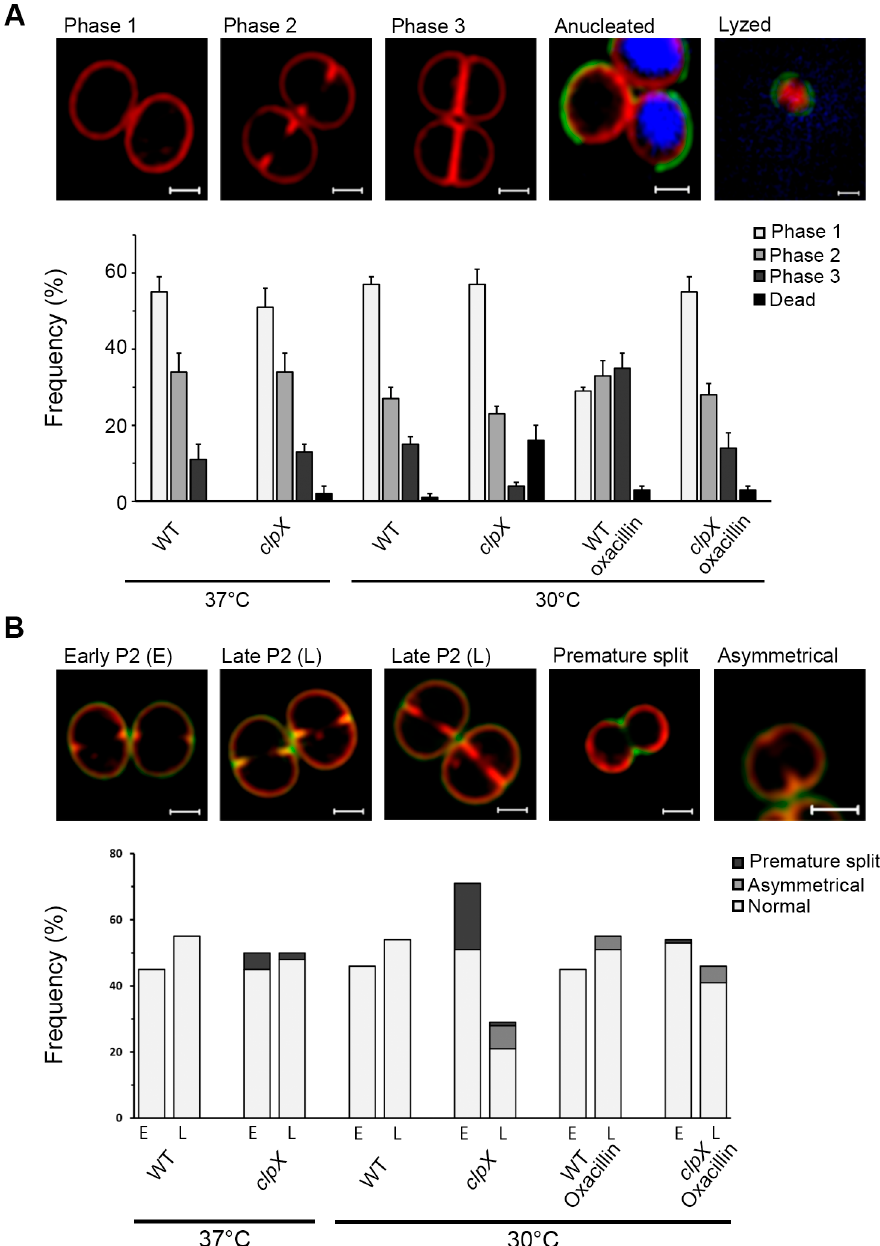
Fig 4. Oxacillin restores progression of the cell cycle in S . aureus clpX cells grown at 30˚C. SA564 wild-type and clpX cells were grown at 37˚C or 30˚C as indicated in the absence or presence of 0.05 μ g ml -1 oxacillin ( A and B ); cells were then stained with the membrane dye Nile Red (red) and the cell wall dye Van-FL (green) before imaging by SR-SIM. To examine if ClpX alters progression of the growth cycle, 300 cells (from each of two biological replicates) were scored according to the stage of septum ingrowth: no septum (phase 1), incomplete septum (phase 2), or non- separated cells with complete septum (phase 3), according to the examples images shown in the ( A ) top panel. To estimate the fraction of dead cells, the DNA dye Hoechst 3334 was used to identify anucleated and lysed cells–see two examples depicted to the right in the top panel. Scale bar, 0.5 μ m. ( B ) Phase 2 cells (200 phase 2 cells for each biological replicate) were additionally scored according to the state of septum ingrowth (cells with less than 15% septum ingrowth were scored as “early” (E), while cells with more than 15% septum ingrowth were scored as “late” (L)), and whether the ingrowth was asymmetrical, as shown in the example images in the top panel. The proportion of cells presenting premature split was estimated based on the Van-FL staining. Scale bar, 0.5 μ